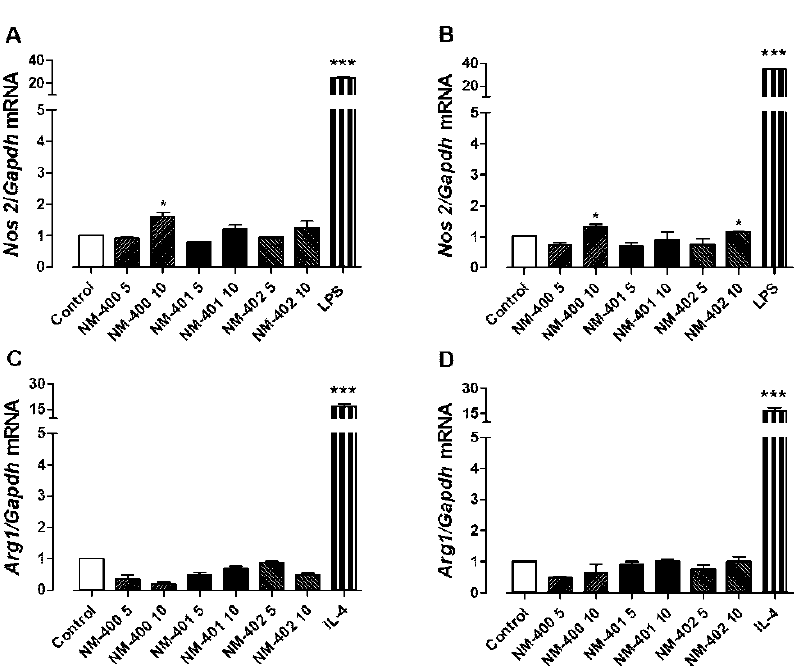
Figure 3. Nos2 and Arg1 expression in murine macrophages. Raw264.7 ( A , C ) and MH-S ( B , D ) macrophages, grown for 24 h in complete growth medium, were treated with 5 or 10 µ g / cm 2 of NM-400, NM-401, or NM-402 for 48 h. At the end of treatment, mRNA was extracted, and the expression of Nos2 (A,B) or Arg1 (C,D) was evaluated as described in the Materials and Methods. LPS (100 ng / mL) and IL-4 (10 ng / mL) were used as positive controls for, respectively, Nos2 and Arg1 induction. The experiment was performed twice with comparable results. Data are the means ± S.D. of two independent determinations, each performed twice. * p < 0.05 and ** p < 0.01 vs. untreated, control cells, as assessed with the t -test for unpaired data.